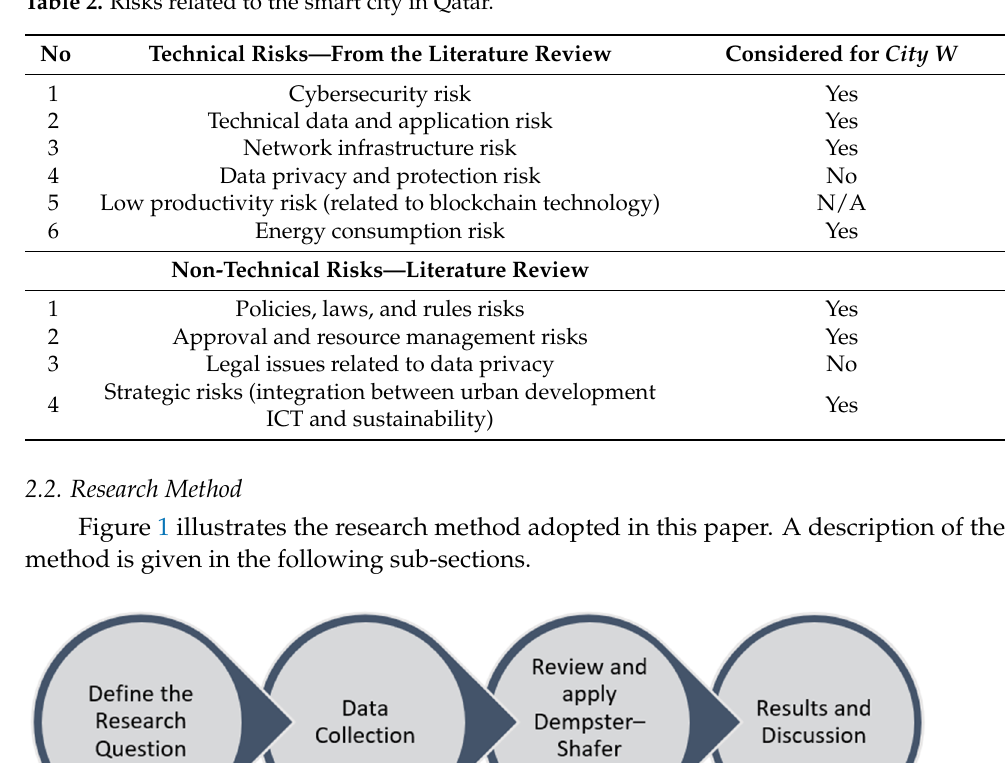
Table 2. Risks related to the smart city in Qatar.